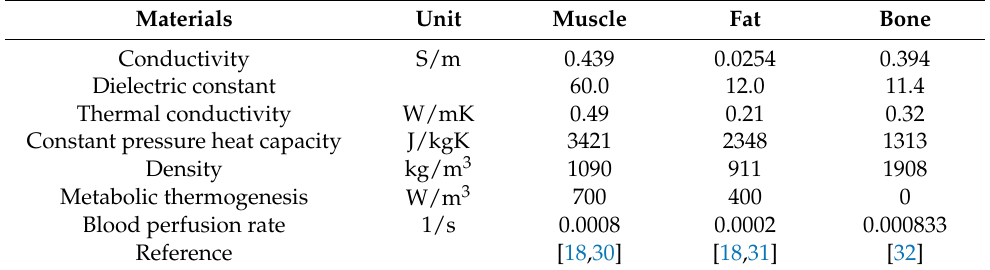
Table 1. Electrical and thermo-physical properties of different biomedical tissue in MWA modeling. Materials Unit Muscle Fat Bone Conductivity S/m Dielectric constant 60.0 Thermal conductivity W/mK 0.49 Constant pressure heat capacity Density Metabolic thermogenesis Blood perfusion rate